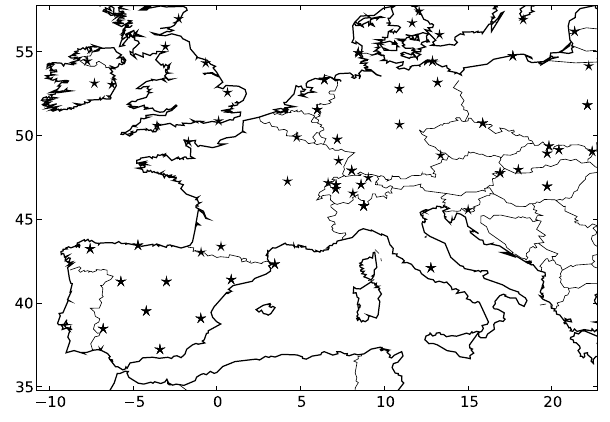
Fig. 1. Locations of the EMEP observation stations for